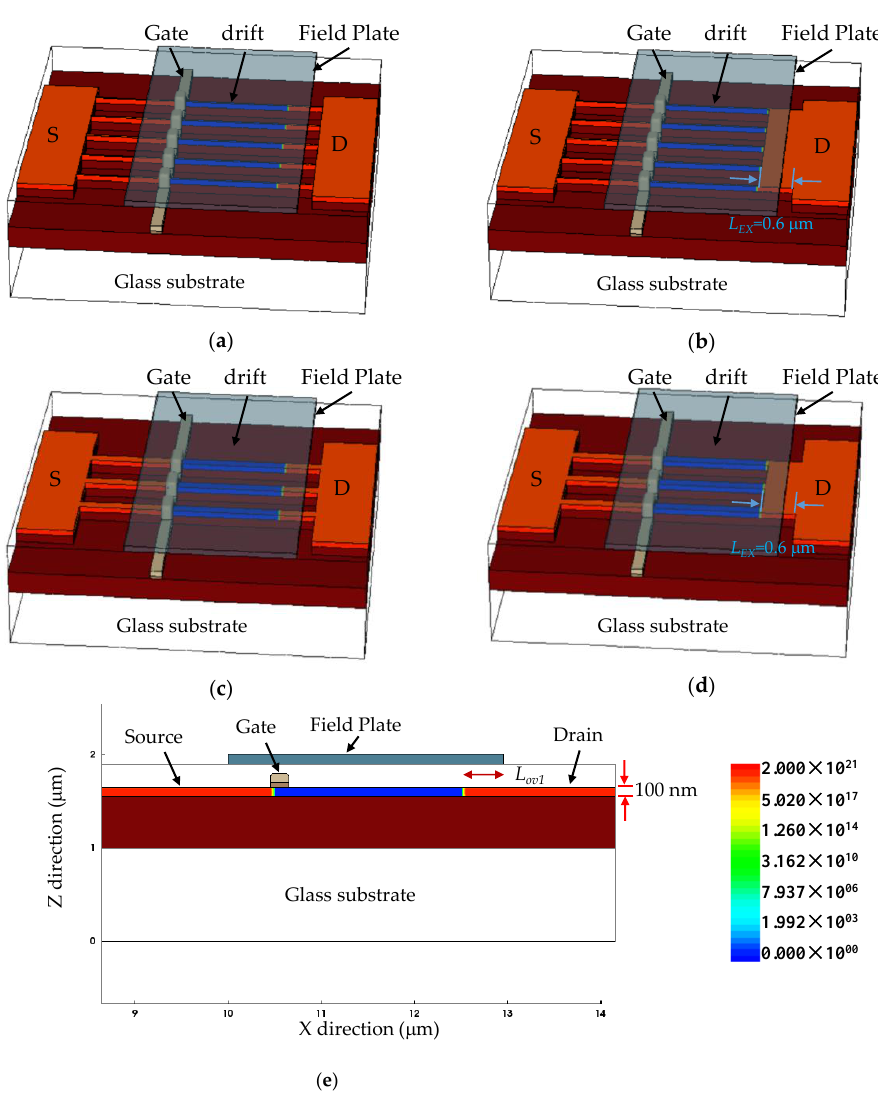
Figure 1. 3-D structure of FinTFTs: ( a ) W40 with L EX = 0 μm ; ( b ) W40 with L EX = 0.6 μm ; ( c ) W200 with L EX = 0 μm ; and ( d ) W200 with L EX = 0.6 μm ; ( e ) Cross-section view of FinTFT.